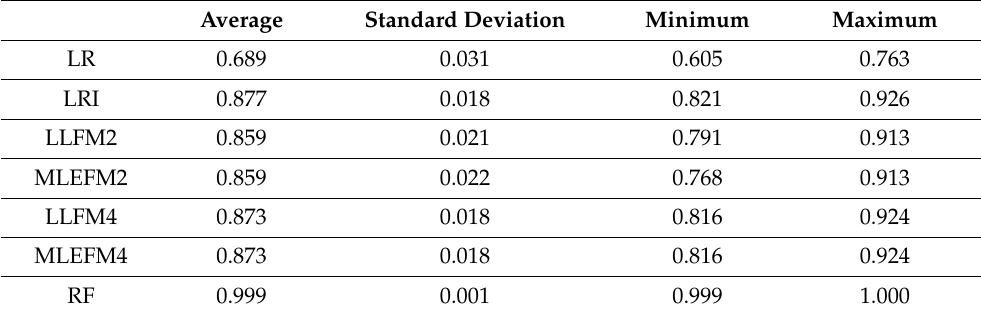
Table 9. Fitted Ginis on the training set obtained over 200 simulation